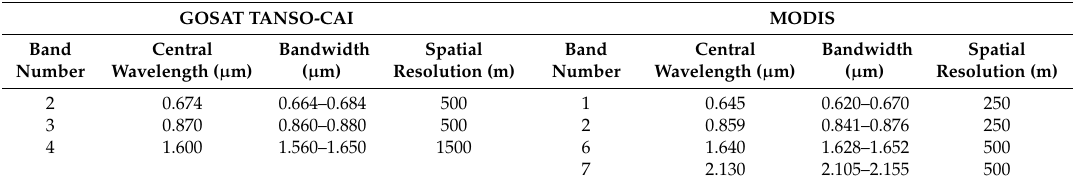
Table 1. Parameters of the corresponding Greenhouse Gases Observing Satellite Thermal and Near-Infrared Sensor for Carbon Observation Cloud and Aerosol Imager (GOSAT TANSO-CAI) and MODIS bands used in this study.